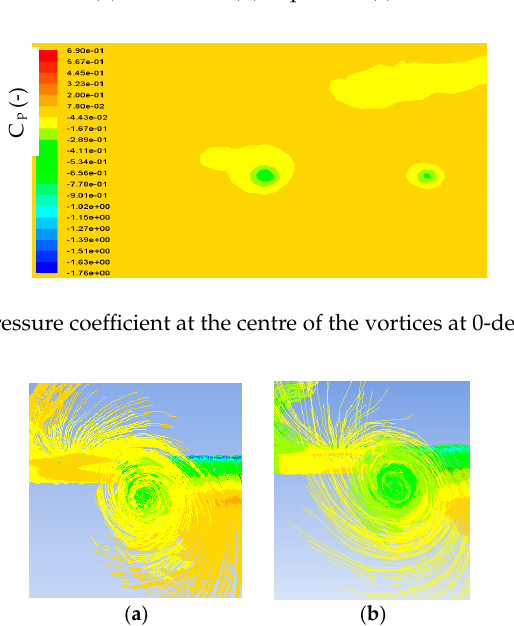
Figure 15. Images showing the vortex size for the conventional wing ( a ) at 0 degrees’ angle of attack ( b ) at 5 degrees’ angle of attack.